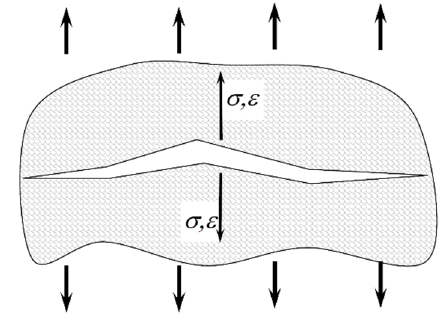
Figure 1. Interpretation of the SWT parameter defined by the normal component.